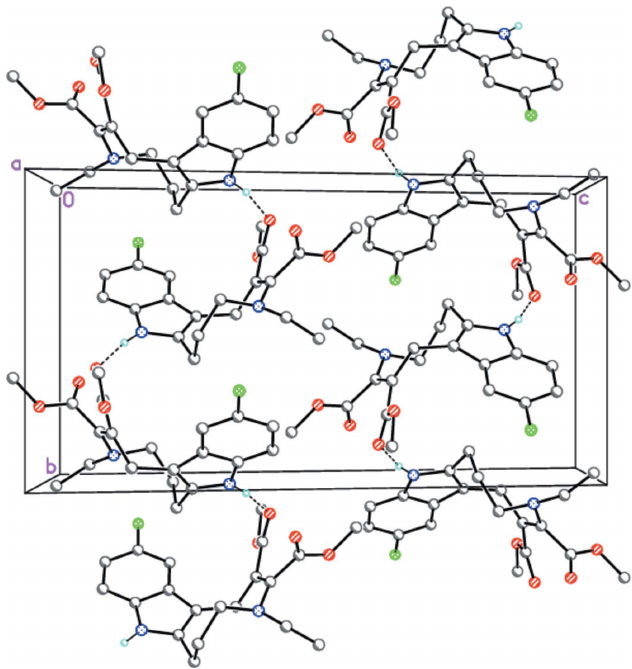
Figure 3 The crystal packing of I viewed along the a -axis direction showing the zigzag chains along [010]. Dashed lines indicate intermolecular N— H (cid:3)(cid:3)(cid:3) O hydrogen